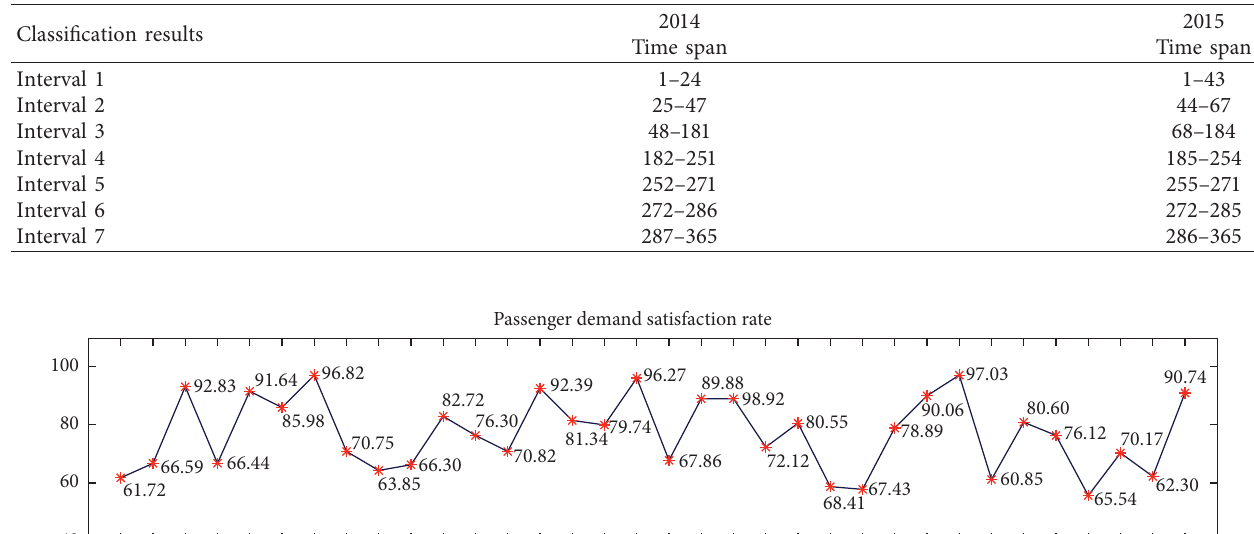
Table 2: Amended classification of the passenger flow